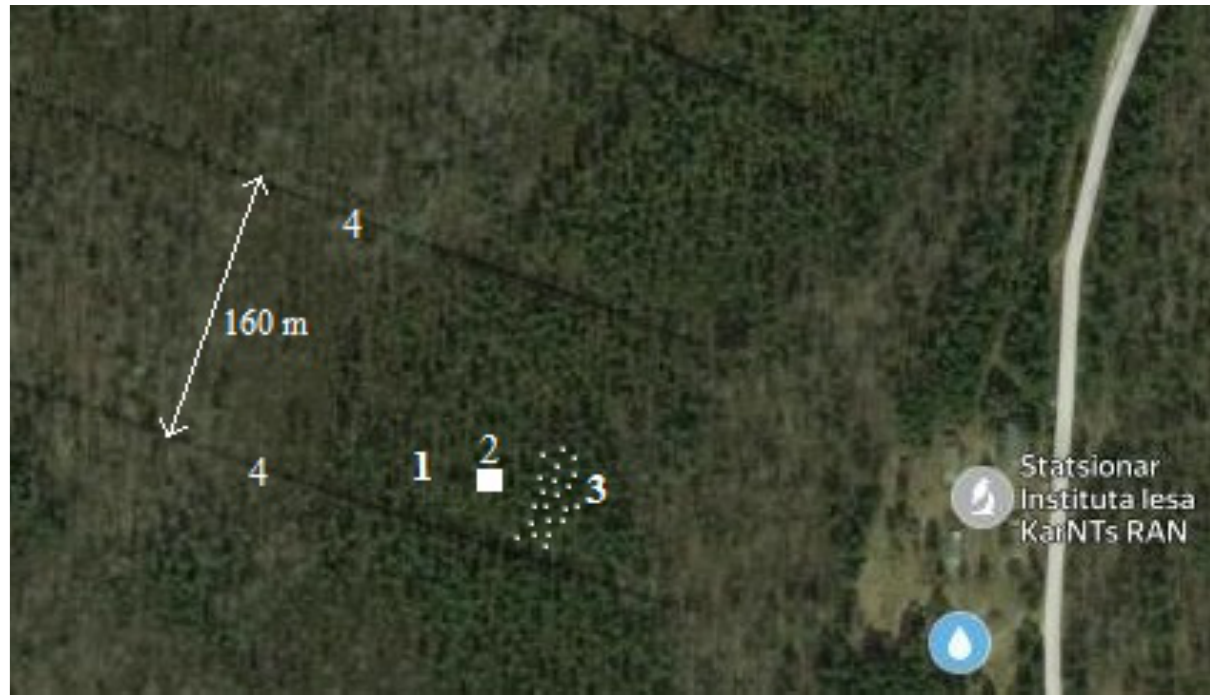
Figure 1. Aerial view of the study site (meso-oligotrophic dwarf shrub- Sphagnum pine stand). 1: sample plot (SP; 0.5 ha); 2: permanent sample plot (PSP; 100 m 2 ); 3: permanent monitoring plots (PMPs; 1 m 2 ); 4: melioration